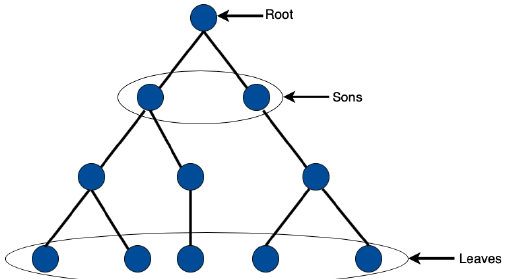
Figure 1. A tree t of depth d = 3 with fanout p = 2. There are 2 subtrees ( | s ( t ) | = 2), 6 internal nodes (inode ( t ) = 6), and 5 leaves (leaves ( t ) =